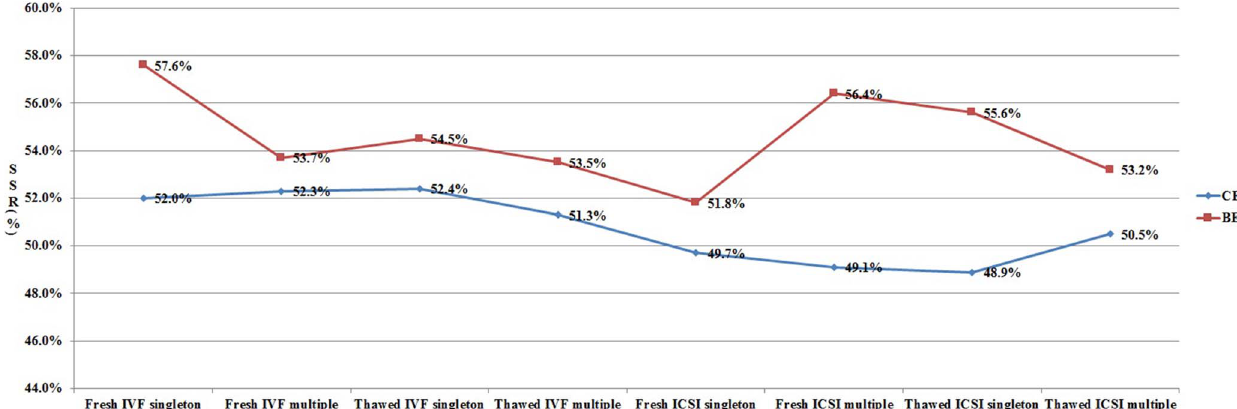
Figure 2. Effect of stage of embryo transferred (CE/BE) on SSR. SSR= secondary sex ratio; IVF= in vitro fertilization; ICSI= intracytoplasmic sperm injection; CE= cleavage stage embryo; BE= blastocyst embryo.